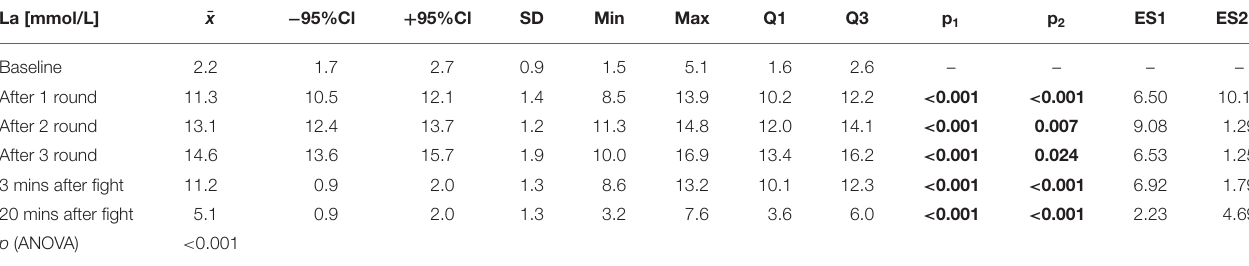
TABLE 2 | Lactate concentration in subsequent measurements.